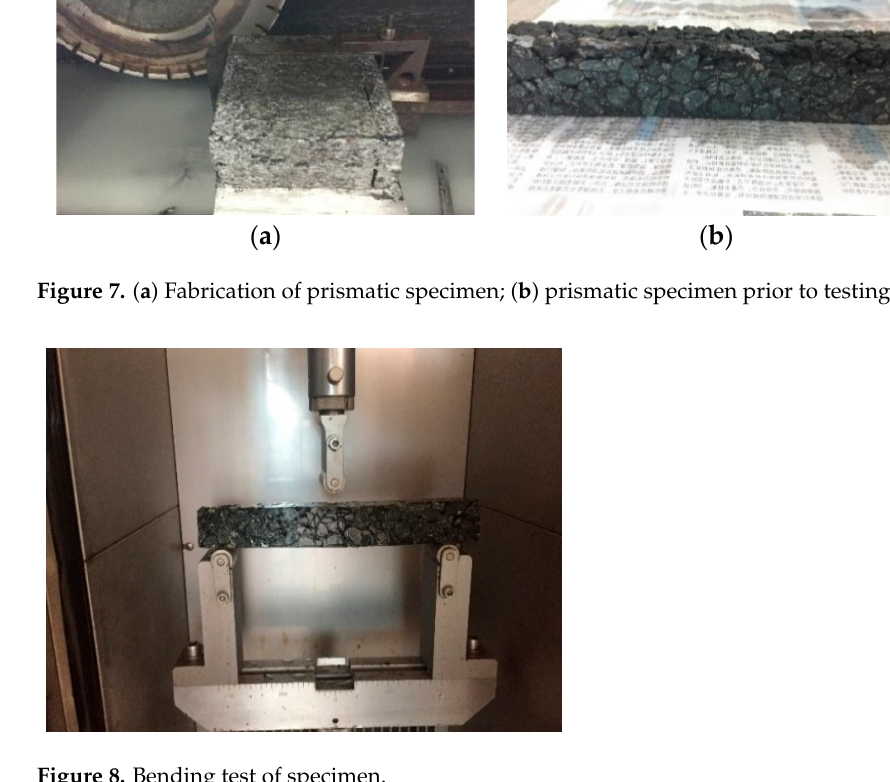
Table 14. Results of low temperature bending test.